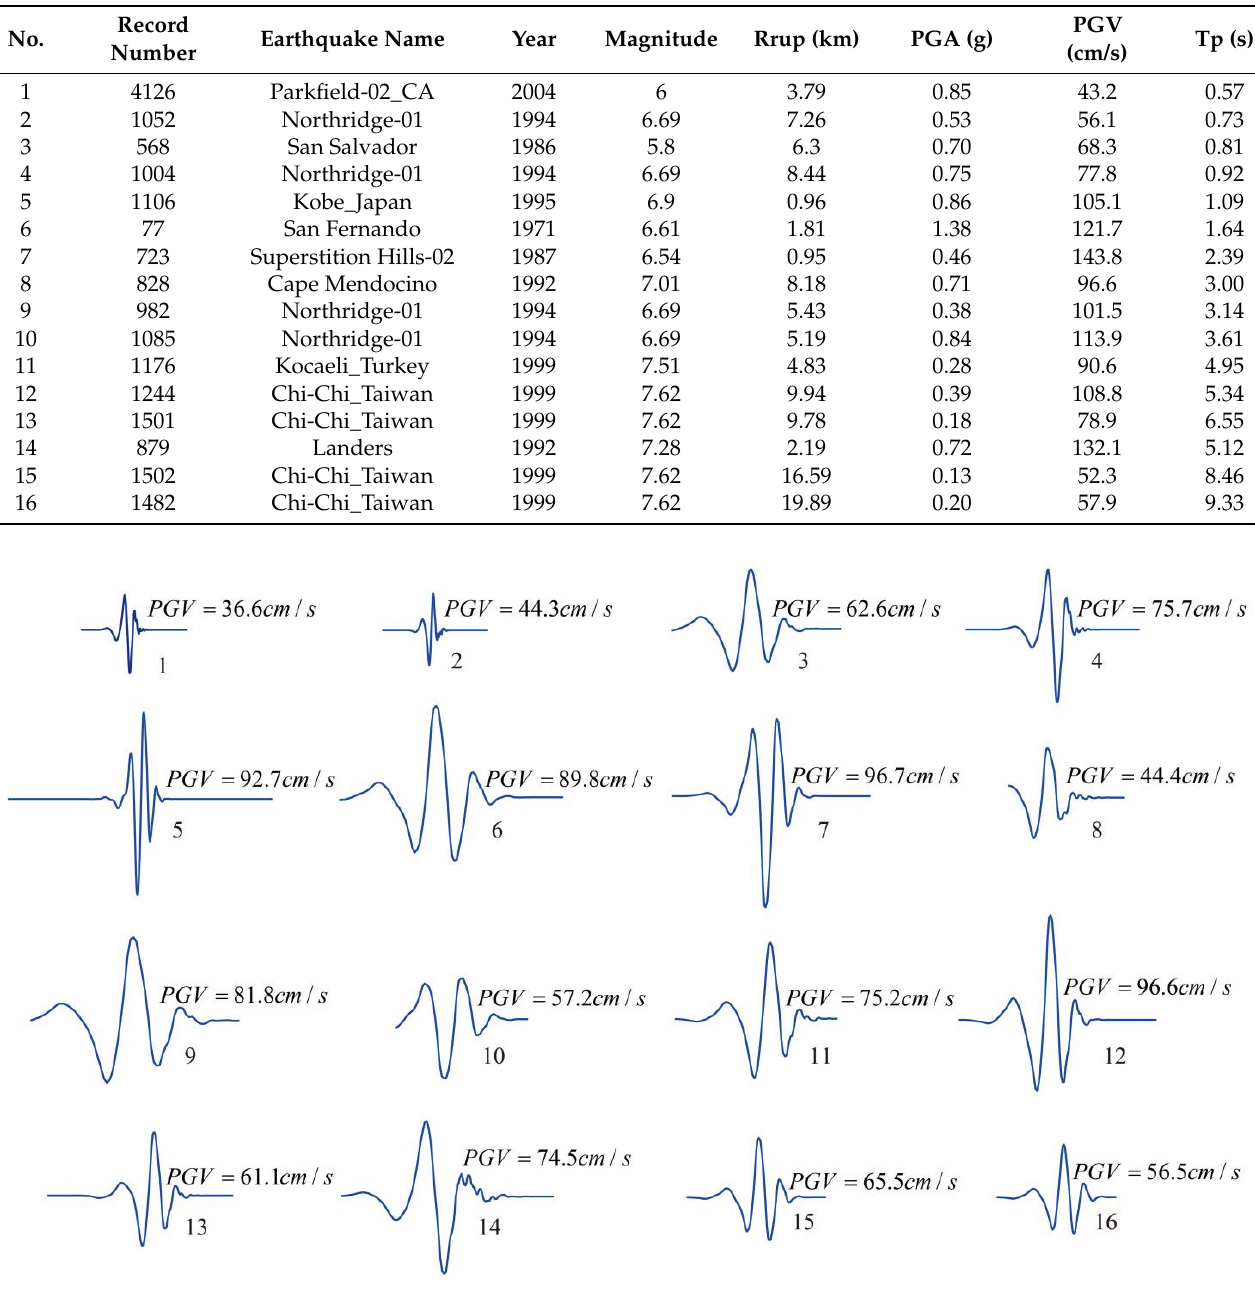
Table 1. Ground motions with forward-directivity effects.